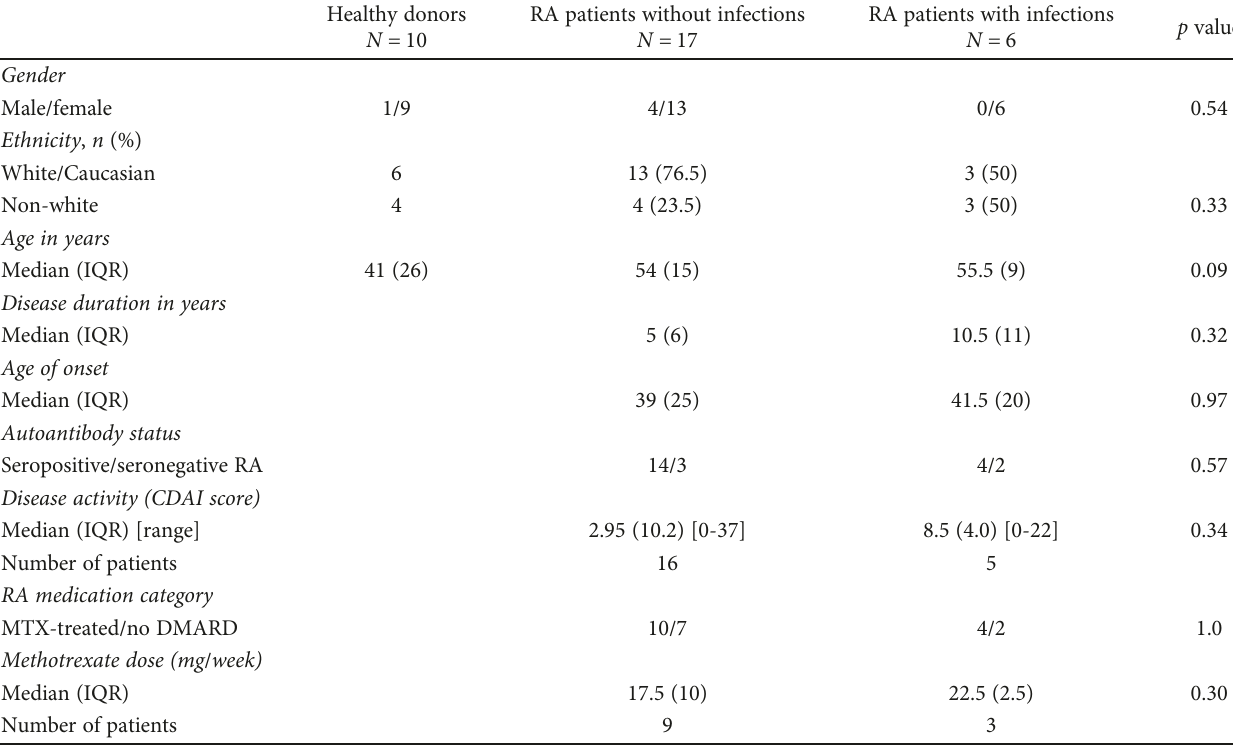
Table 1: Basic demographic and clinical characteristics of RA patients and RA